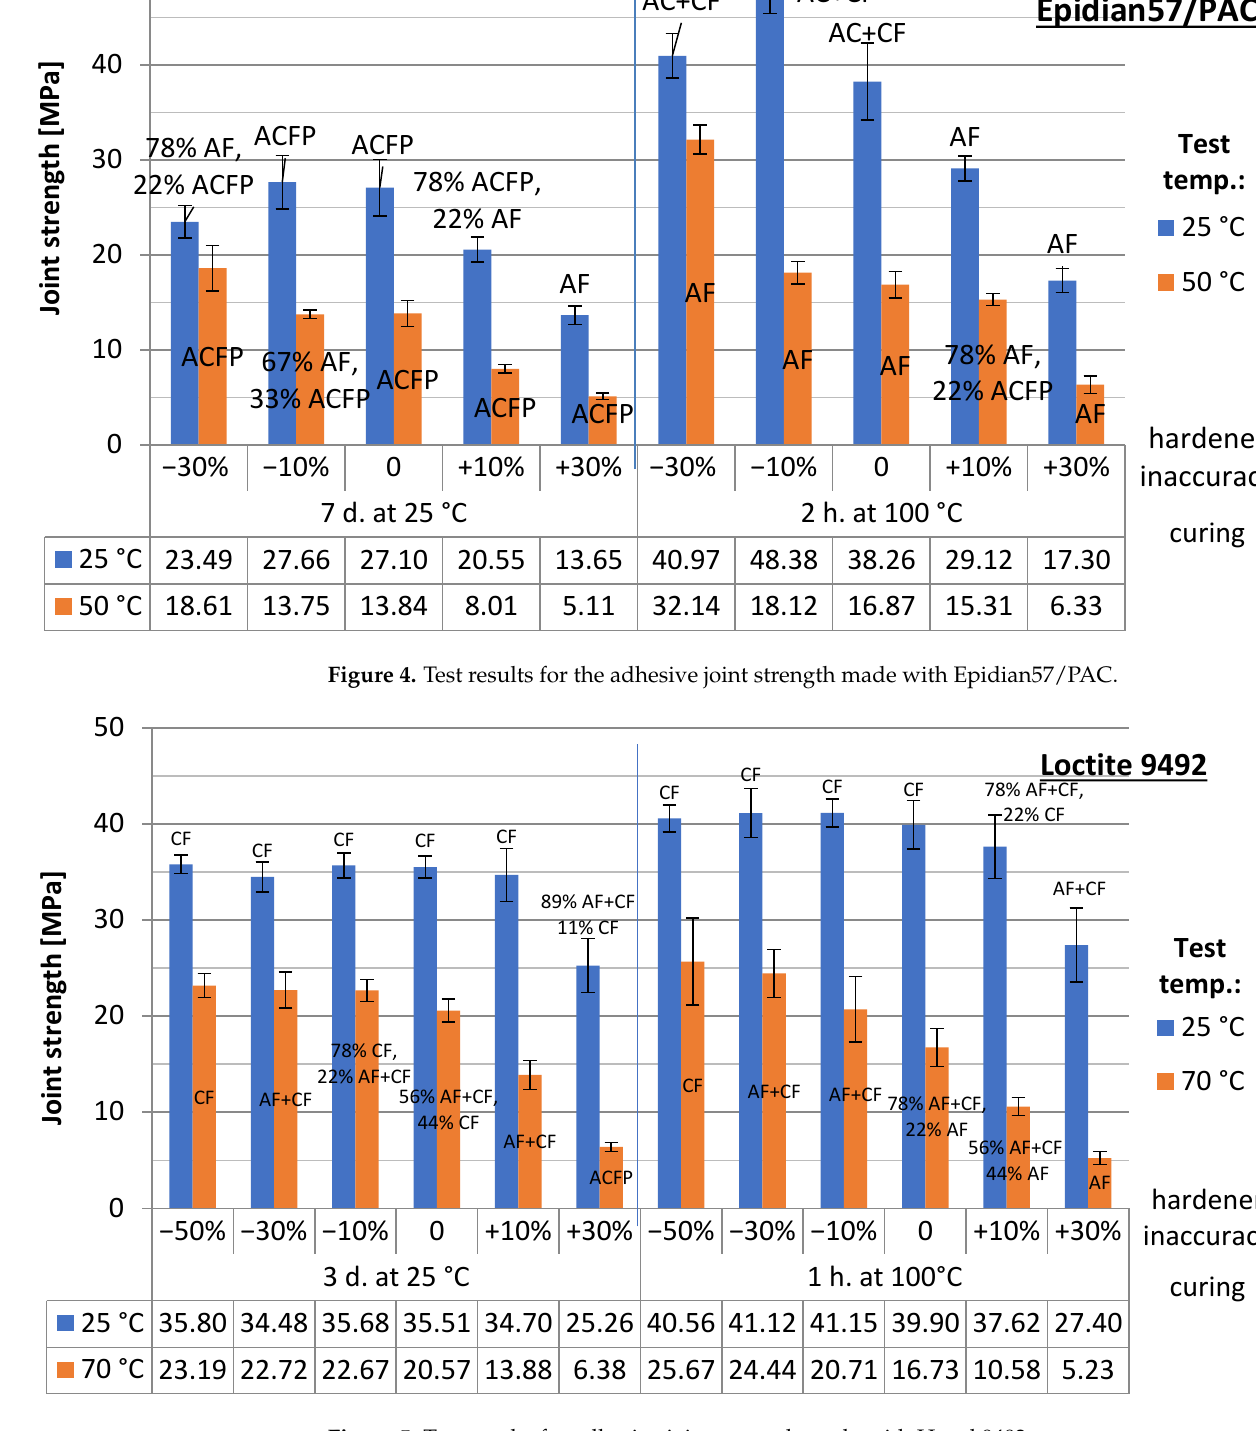
Figure 5. Test results for adhesive joint strength made with Hysol 9492.